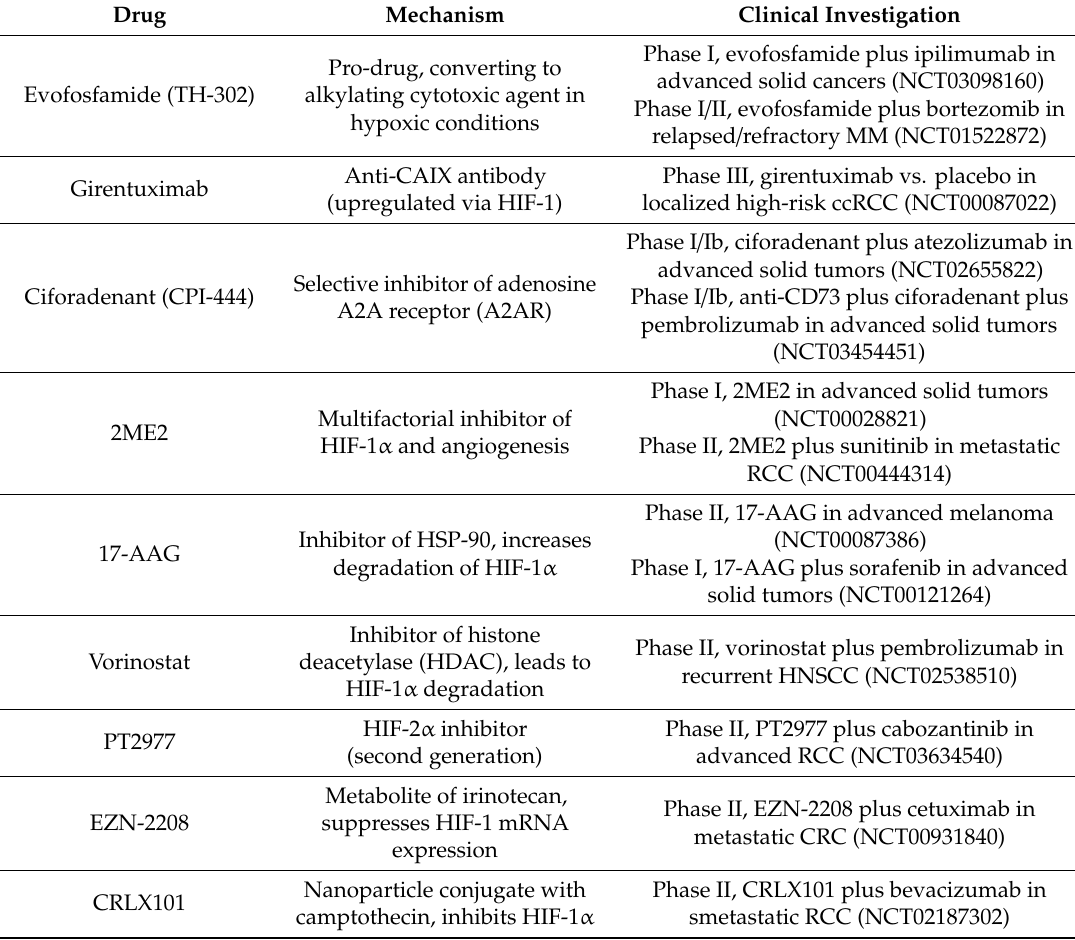
Table 1. Hypoxia-targeted drugs under investigation with select clinical